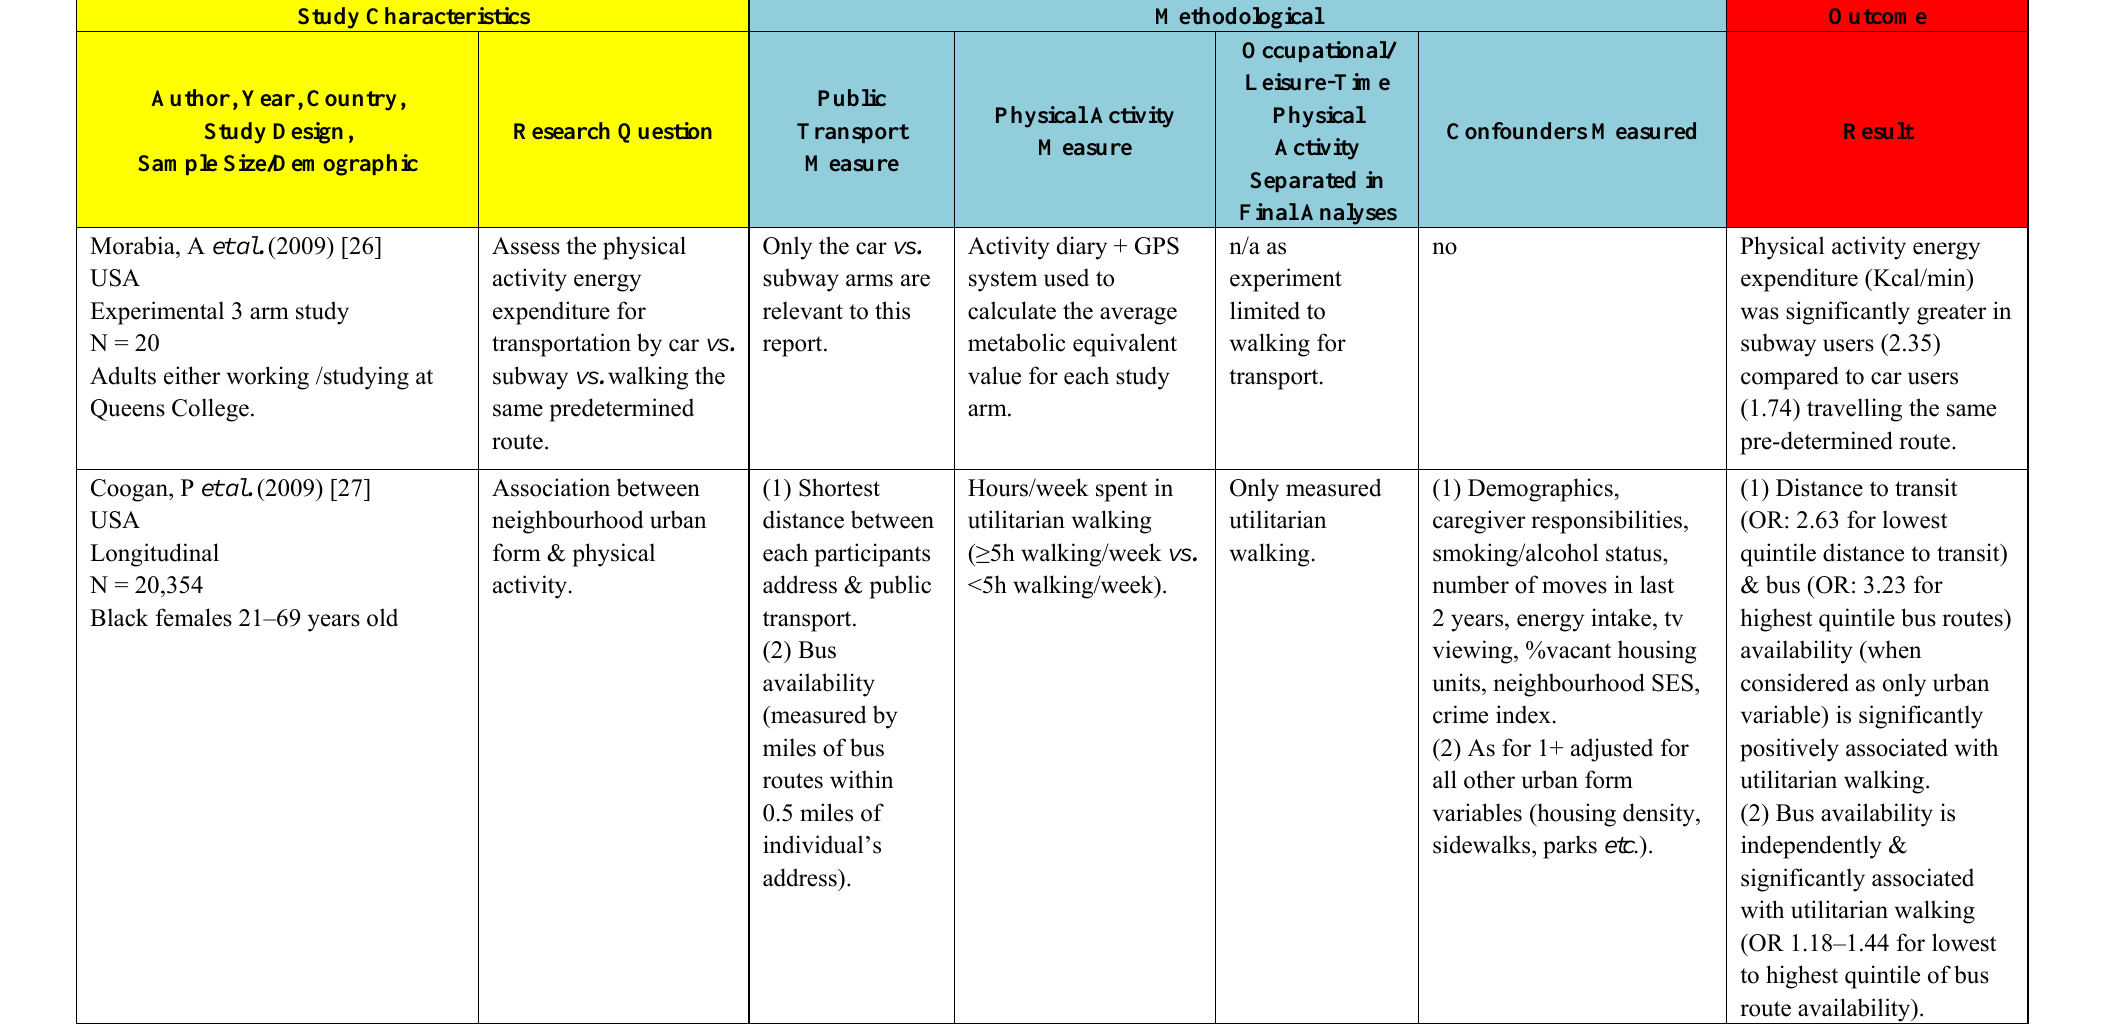
Supplementary Table S1. Studies reporting associations between the use of public transport and health outcomes in